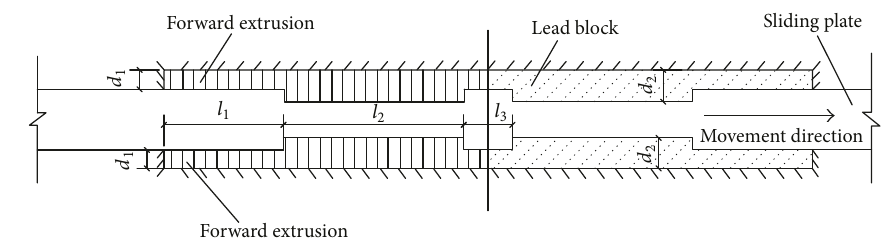
Figure 4: Structure and dimension of ILSD-LS.